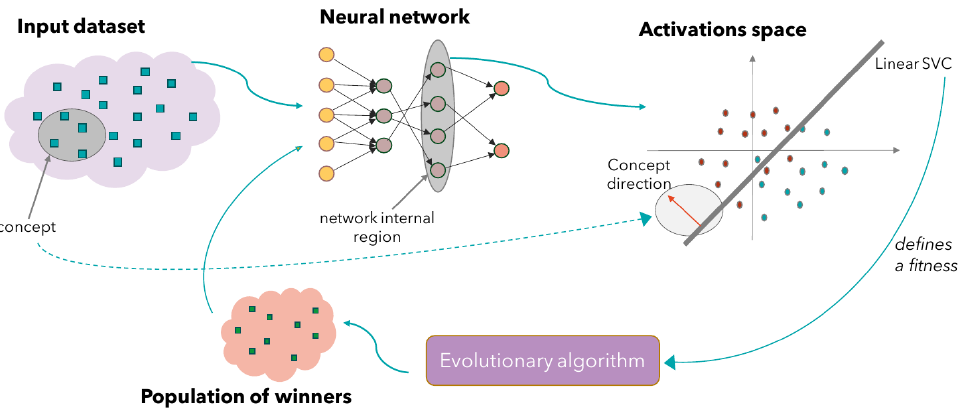
Figure 1. Approach